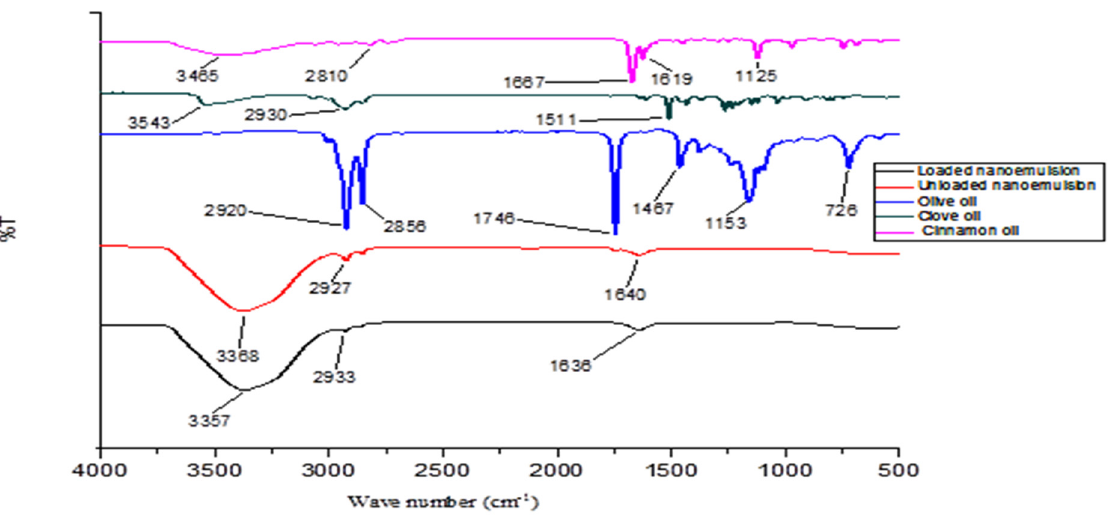
Figure 1. FTIR spectra of olive oil, cinnamon oil, clove oil, essential loaded nanoemulsion and unloaded nanoemulsion.